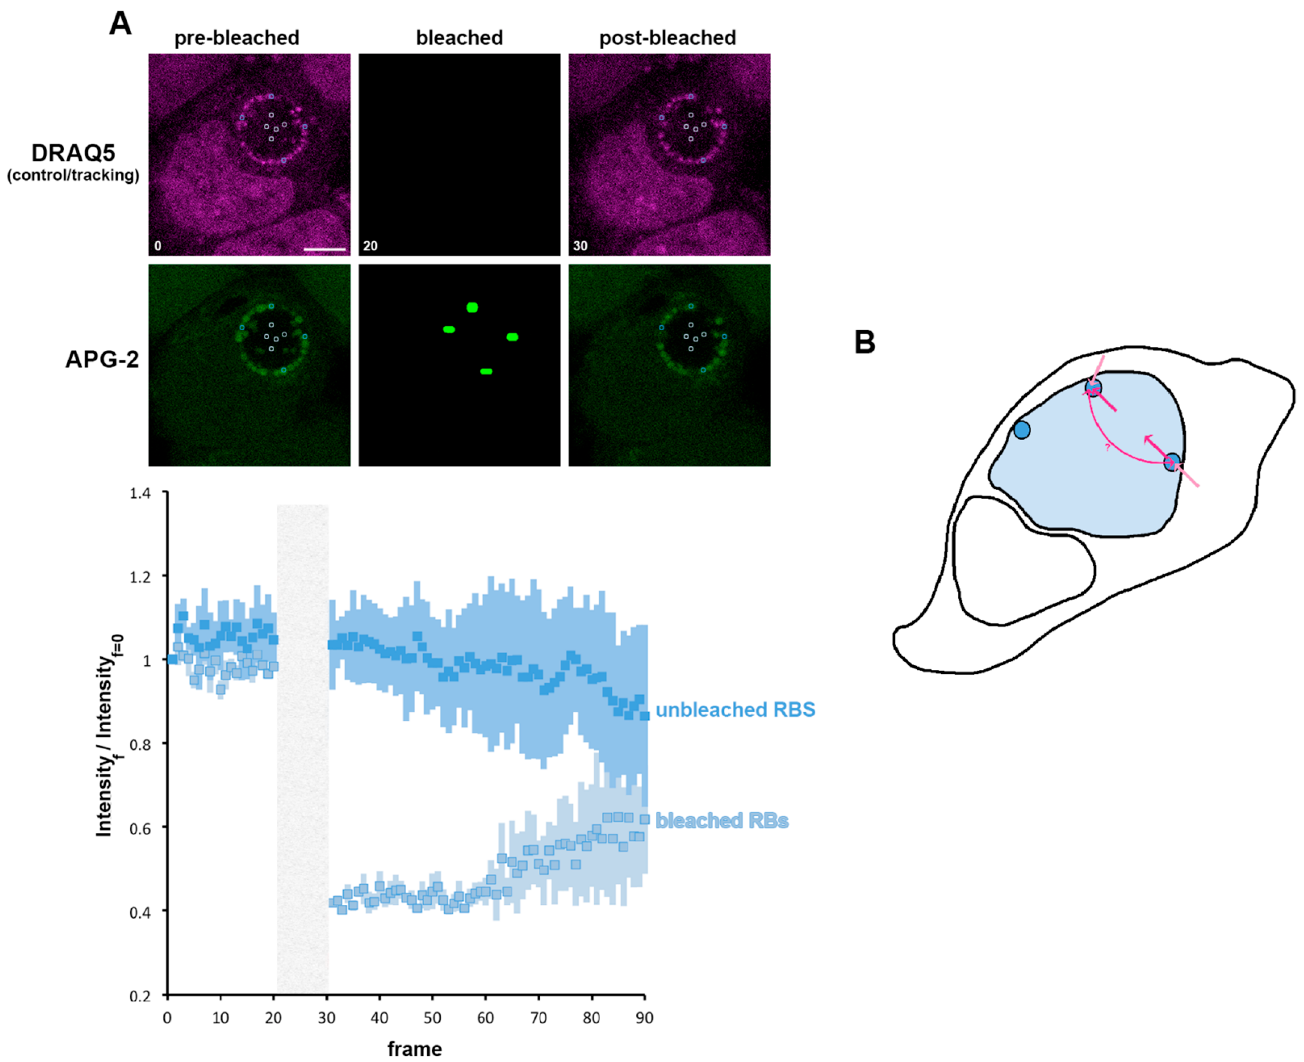
Figure 8. K + is exchanged between reticulate bodies. ( A ) HeLa cells were infected with C. trachomatis LGV2. At 24 hpi cells were labelled with APG-2 and DRAQ-5 and then imaged. APG-2 was photobleached as indicated on the upper panels in some reticulate bodies (RBs). Circles show the region of interest used for the analysis of the intensity depending on the frame (lower panels: 1.509 s/frame) presented on the lower panels. Dark blue: unbleached RBs and light blue: bleached RBs. Scale bar: 5 µm. ( B ) Shows schematics of the proposed K + flux (pink arrows), between the host cytoplasm (white) the inclusion lumen (light blue) and the bacteria (dark blue).